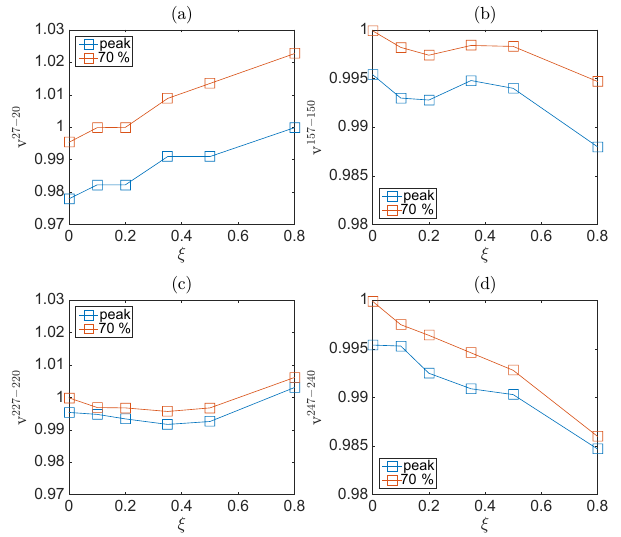
Figure 9. Panel (a) is the temporal Fourier transform of displace- ment of particles for normal distribution and disorder parameter ξ = 0 . 01 (single realization) with group velocity ( v g ) depicting the propagation of the wave front, and (b) is the temporal as well as spatial Fourier transform (two-dimensional FFT, single realization) calculated for obtaining the dispersion relation of a chain, while (cid:104) (cid:127)(k) (cid:105) gives the true ensemble-averaged (500) dispersion relation from Eq. (43). Panels (c, d) are the higher-disorder ξ = 0 . 35 coun- terparts of (a, b) ,